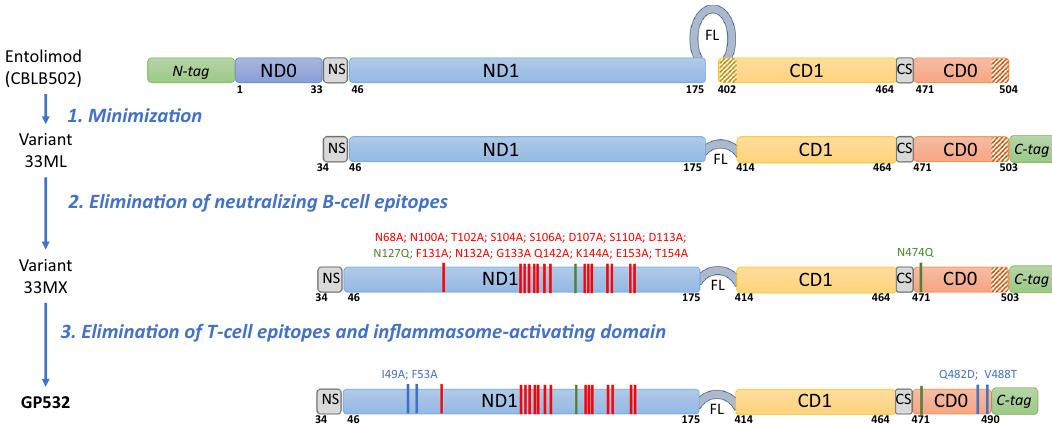
Fig. 2 Three-stage engineering of the partially deimmunized and pharmacologically optimized TLR5 agonist GP532 from parental entolimod (CBLB502). N-terminal and C-terminal segments of helical domains D0 and D1 are shown in shades of blue and red/yellow, respectively. The His 6 af fi nity tag added to allow protein puri fi cation is shown in green. Unstructured “ spoke ” regions connecting ND0 with ND1 and CD1 with CD0 are labeled “ NS ” and “ CS ” , respectively. The fl exible linker in entolimod and its minimized version in other variants is labeled “ FL ” . Mutations (alanine substitutions) eliminating B-cell epitopes are listed in red above the ND1 segment, with approximate positions shown by vertical red bars. Green font and vertical bars indicate N → Q substitutions eliminating potential glycosylation sites 35 . Alanine substitutions eliminating two T-cell epitopes in the ND1 and CD0 segments are shown with blue font and vertical bars. A third T-cell epitope (and the in fl ammasome-activating domain) was eliminated via truncation of the C-terminal 11 amino acids of fl agellin (indicated by diagonal